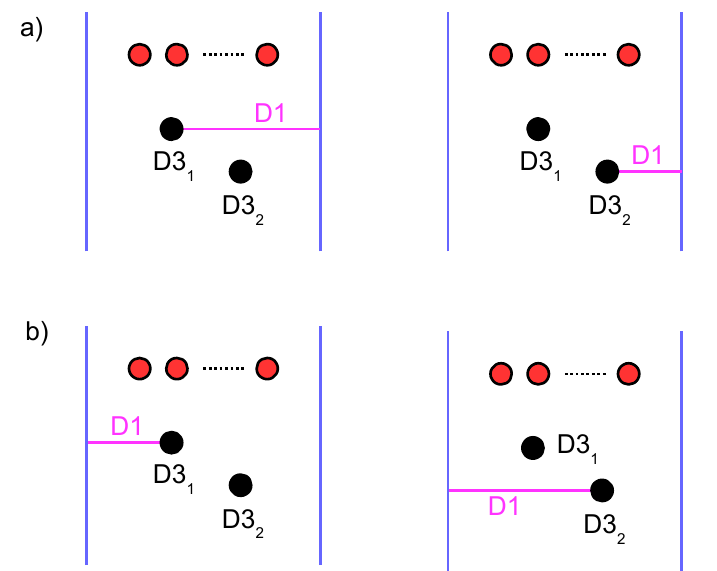
Figure 2 . Brane setups for the two abelian contributions to a) V